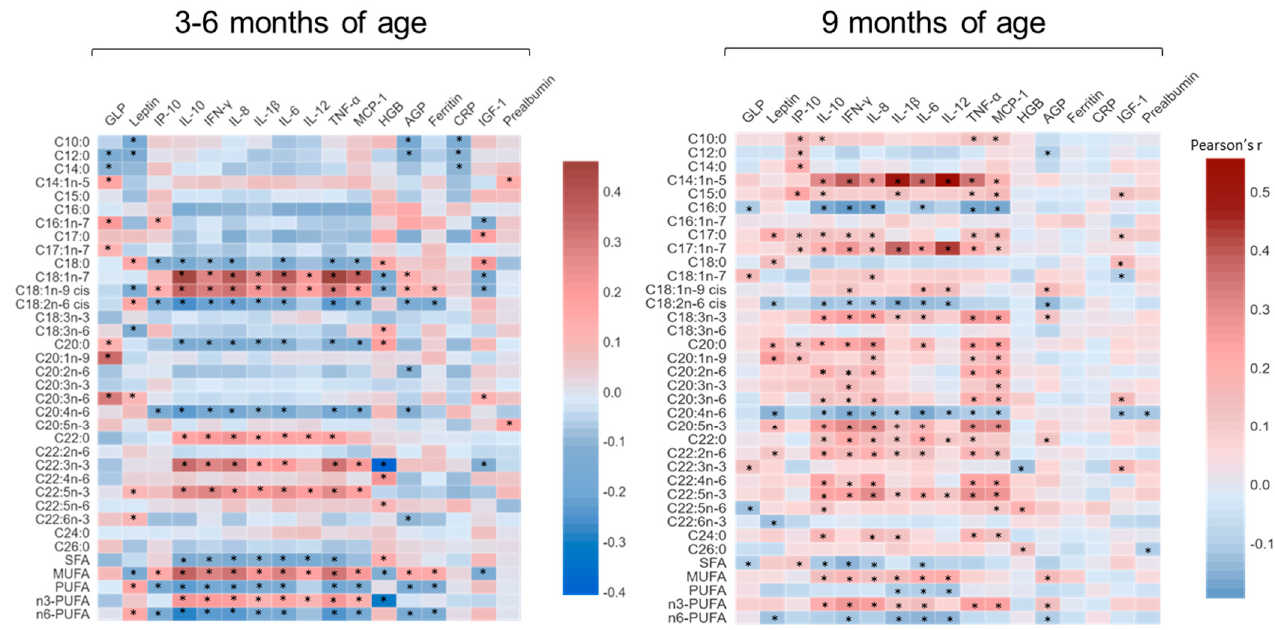
Figure 3. Correlations between NEFAs (%) and cytokines and other EED biomarkers in Pakistani undernourished and healthy children aged 3–6 months and at 9 months. AGP, α − 1 acid glycoprotein; CRP, C − reactive protein; EED, environmental enteric dysfunction; GLP, glucagon − like peptide 2; HGB, hemoglobin; IGF − 1, insulin-like growth factor 1; IL − 8, interleukin 8; IL − 6, interleukin 6; IL − 10, interleukin 10; IL − 12, interleukin 12; IL − 1 β , interleukin 1 β ; INF − γ , interferon − γ ; IP − 10, interferon-inducible protein 10; MCP − 1, monocyte chemoattractant protein 1; TNF − α , Tumor Necrosis Factor alpha; * p < 0.05.